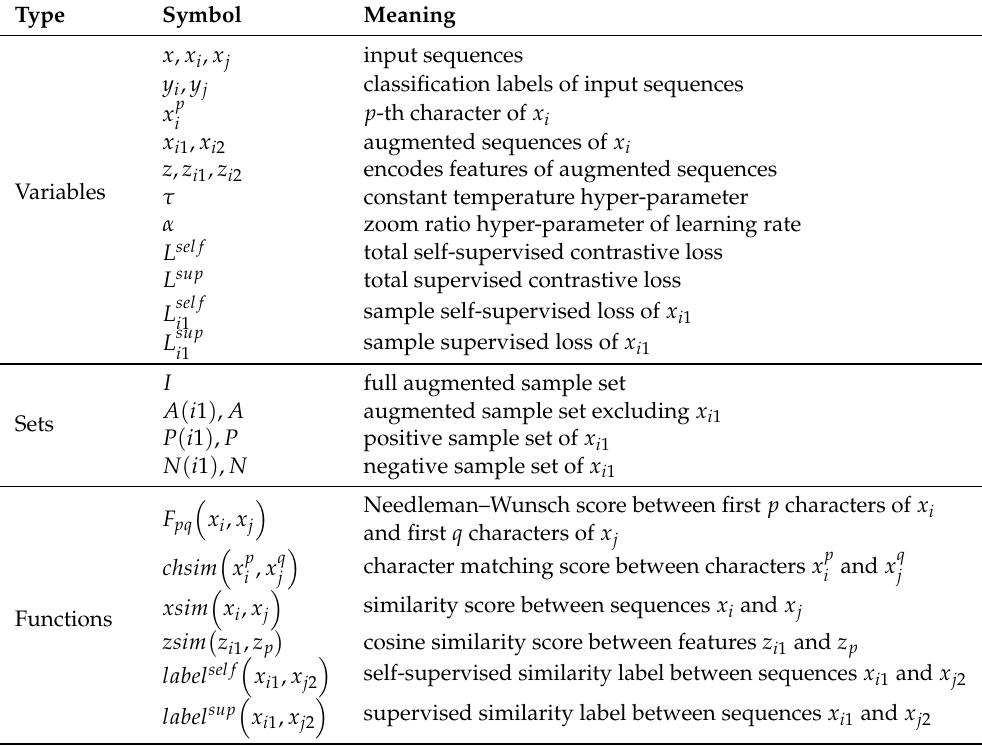
Table 1. A glossary of important symbols in this